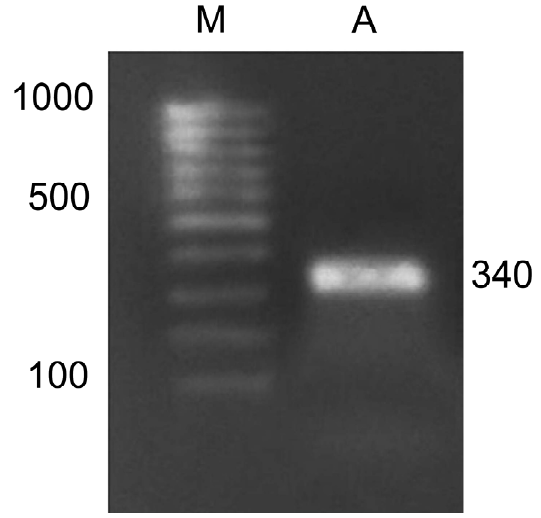
Figure 6. Amplification product of maize cDNA with primers for the Csy1 gene encoding the mitochondrial from of citrate synthase. M, DNA length markers; A, the amplicon.